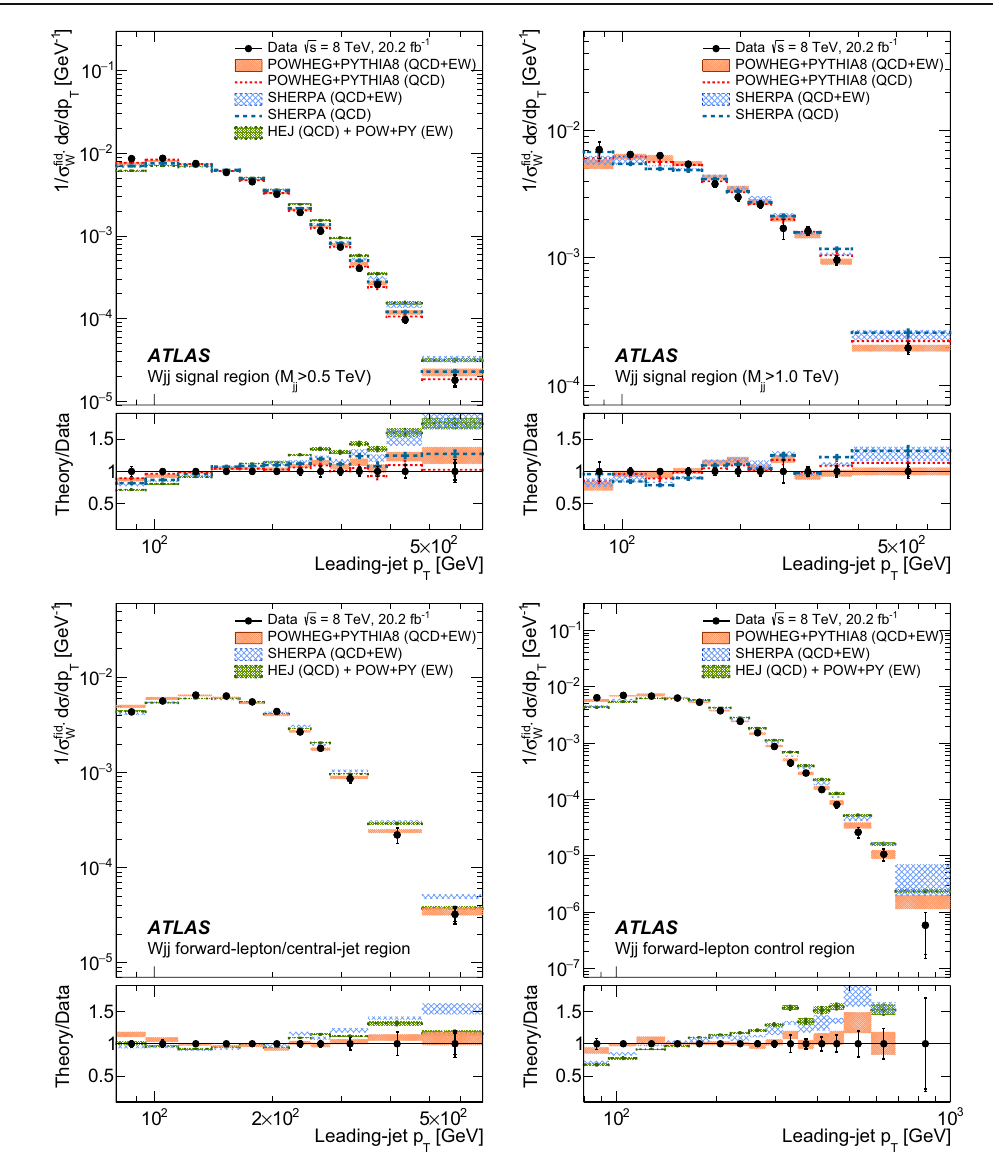
Fig. 24 Unfolded normalized differential W jj production cross sec- tions as a function of the leading-jet p T in the signal, high-mass signal, forward-lepton/central-jet, and forward-lepton regions fiducial regions.